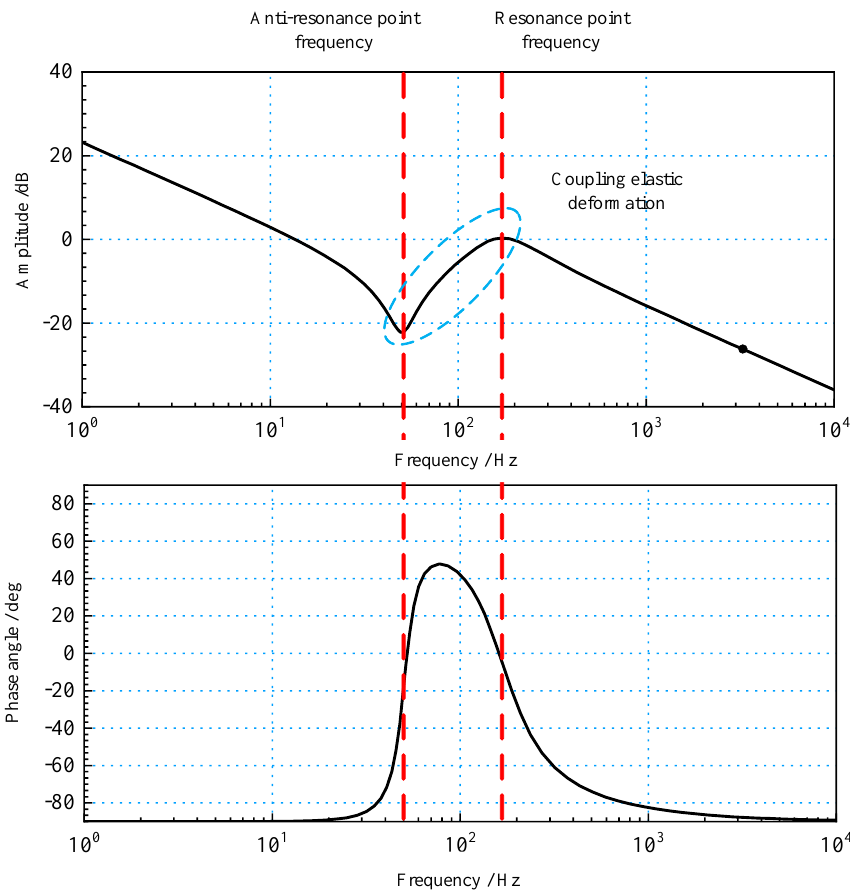
Figure 14. Bode diagram of rotor shaft system dynamic characteristics.